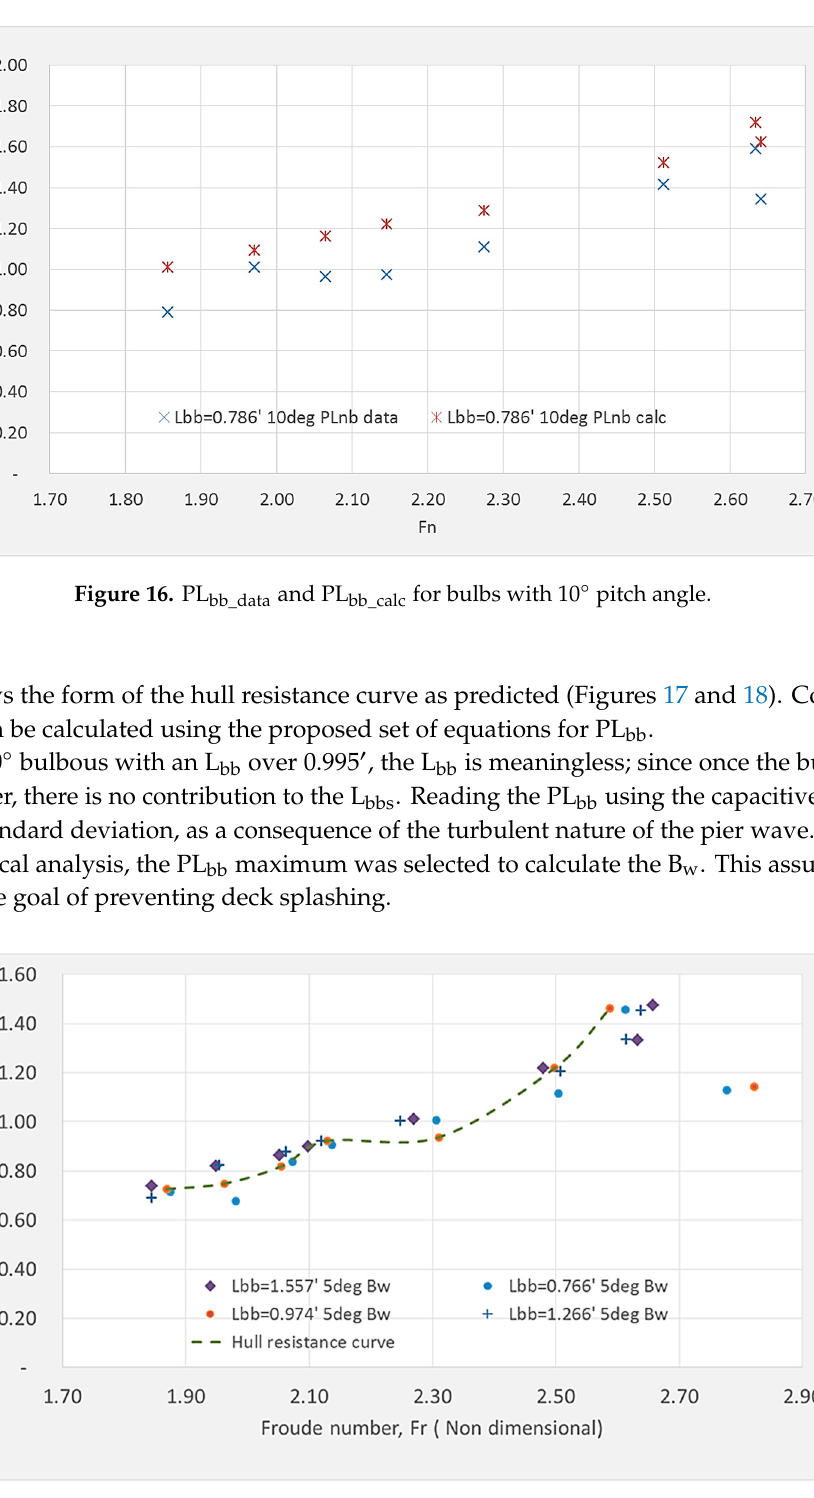
Figure 15. PL bb _ data and PL bb _ calc for bulbs with 5° pitch angle.